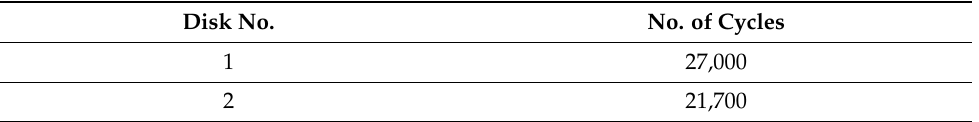
Table 3. Spin rig testing results on two disks. Disk